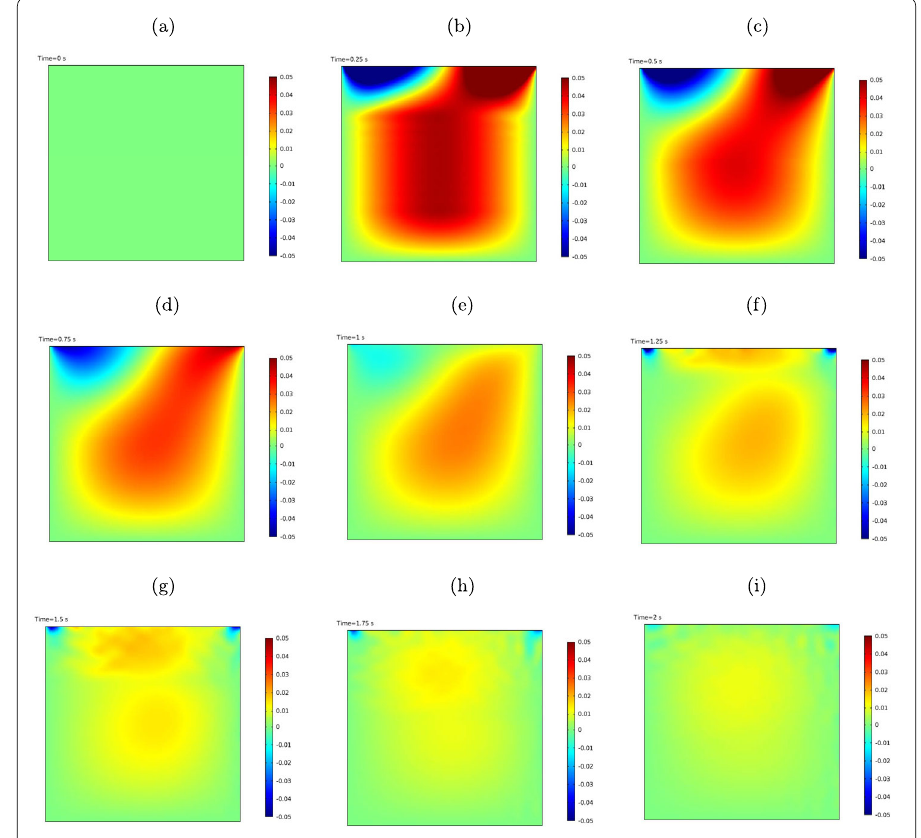
Figure 6 2-d solutions of the wave equation (1.6)-(1.10) with a delay τ = 1 when a ( x ) = 20 and k = 1, at different times: t = 0, ...